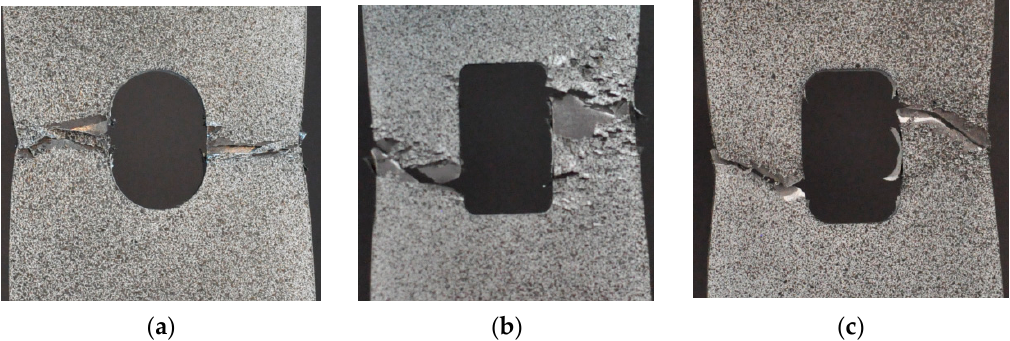
Figure 13. Failure forms of tested samples: ( a ) sample no.2 with a circular hole; ( b ) sample no. 3 with a rectangular hole with a fillet radius R2; ( c ) sample no. 4 with a rectangular hole with a fillet radius R4.